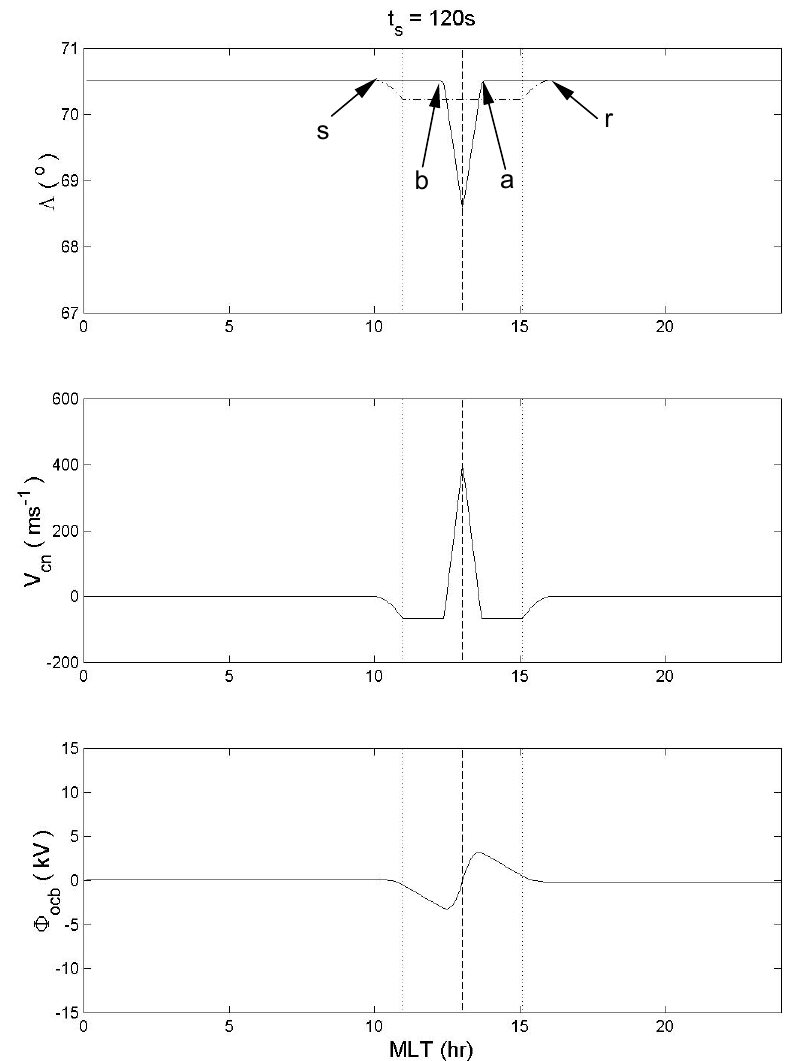
Fig. 4. Output model data for simulation time t s = 120s and as a function of MLT. (a) The latitude of the (solid line) open-closed field line boundary (3 OCB ) and (dot-dashed line) the equilibrium boundary location (3 E ) . (b) The poleward convection velocity at the OCB, V cn . (c) The electrostatic potential around the open-closed boundary 8 OCB . In each panel, the vertical dashed line is the centre of the merging gap and the vertical dotted lines mark the ends of the merging gap ( a and b ) for its maximum